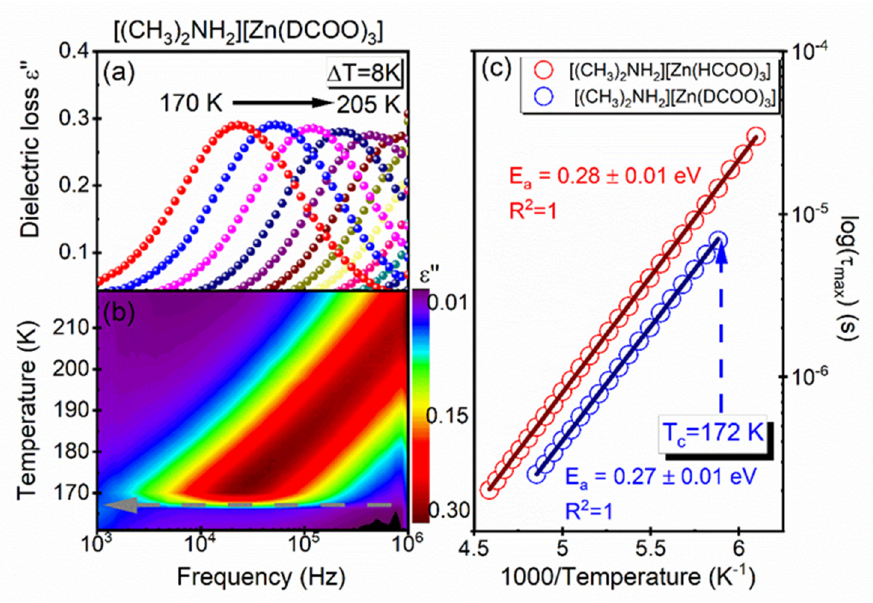
Figure 8. Frequency dependence of ( a ) the loss spectra, ( b ) temperature map and ( c ) relaxation map, with τ as a function of 1000/Temperature.